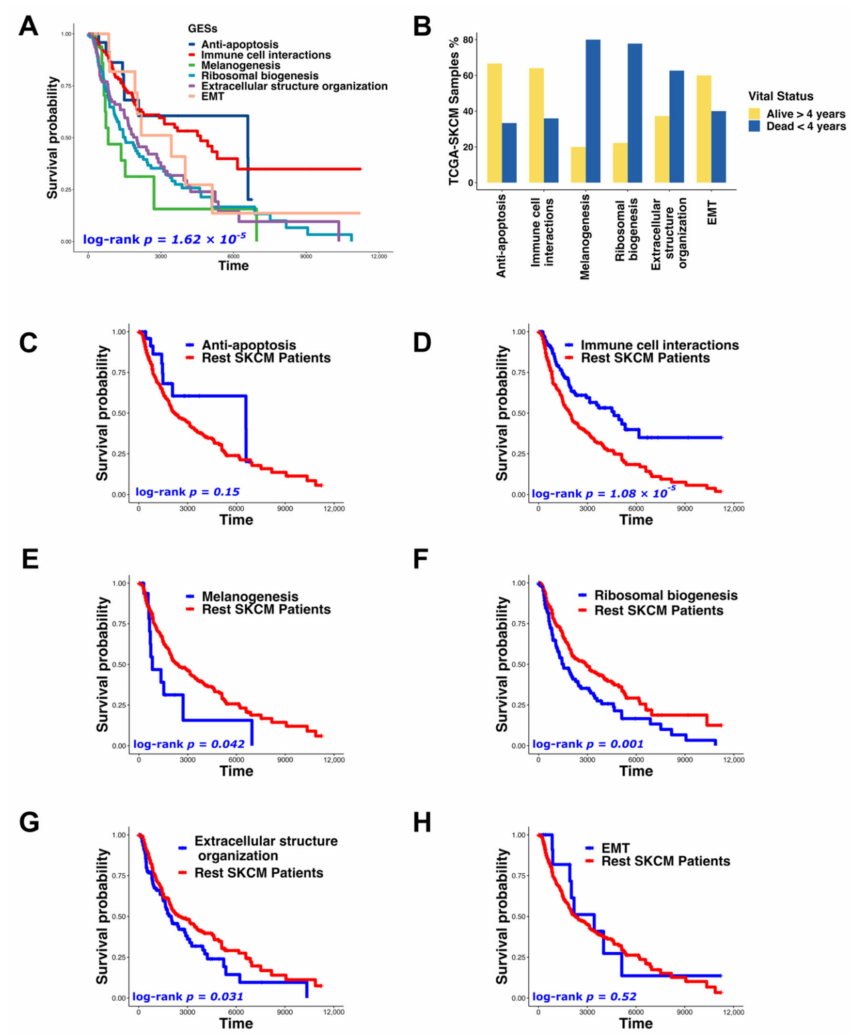
Figure 6. The identified GESs were correlated with melanoma prognosis. ( A ) Kaplan–Meier curve for the survival analysis of TCGA-SKCM patients with different GESs (log-rank p = 1.62 × 10 − 5 ). ( B ) A bar chart representing the proportion of dead (patients who died within the first 4 years) and alive (patients who were alive for more than 4 years) TCGA-SKCM patients with different GESs. ( C – H ) Kaplan–Meier survival curves comparing patients within each GES group (( C ) “Anti- apoptosis”, ( D ) “Immune cell interactions”, ( E ) “Melanogenesis”, ( F ) “Ribosomal biogenesis”, ( G ) “Extracellular structure organization”, and ( H ) “EMT”) with the remaining TCGA-SKCM